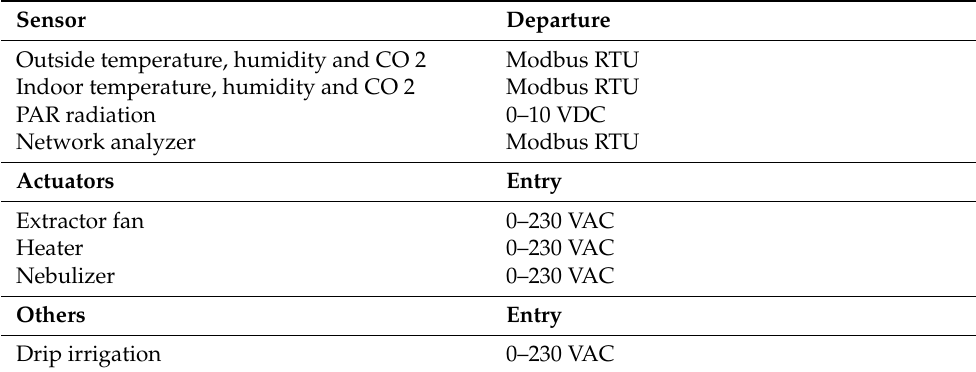
Table 2. Inputs and outputs of system